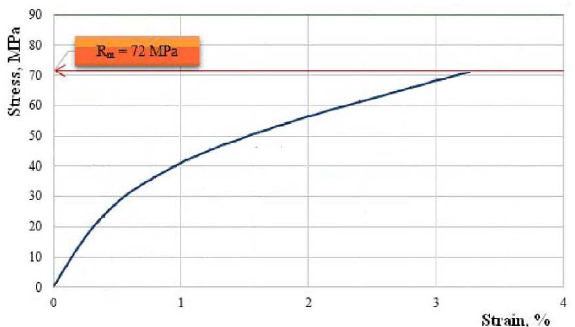
Figure 10. The characteristic curve of a representative sample of composite material with flax fabric reinforcement. Tensile strength R m = 72.0 MPa; elongation at break A = 3.3%; modulus of elasticity E = 5072 MPa.